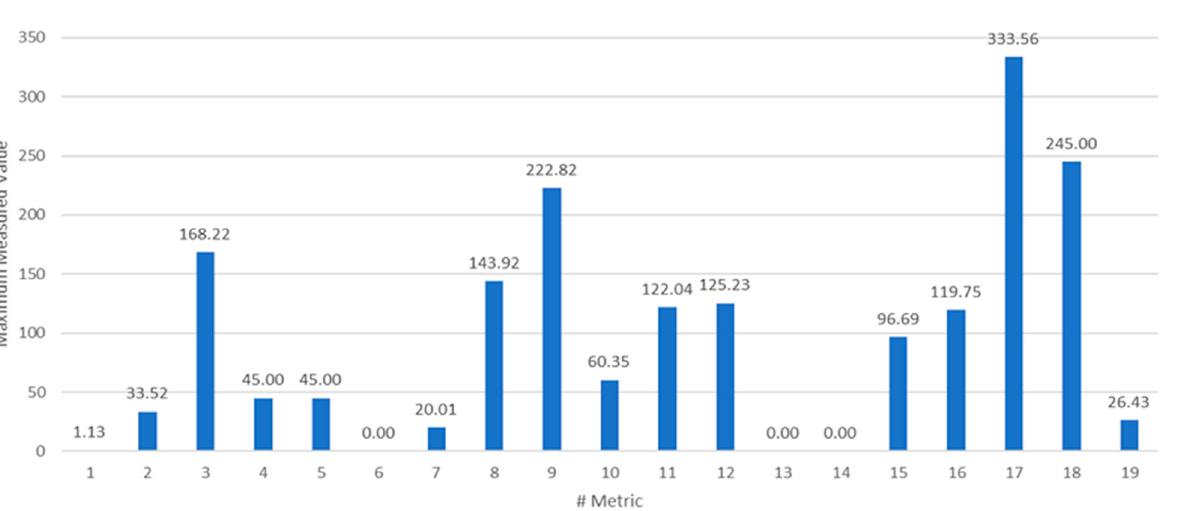
Figure 15. Metrics normalized to the maximum measured values. 6. Experimental Results In this section, we illustrate the application of the Bayesian estimator to real data metrics. Specifically, we assume that the metrics are affected by generic acquisition noise, and we prove that they are corrected by the estimator. The nonlinearity parameters p 0 and β 0 are assigned values of 0.1 and 0.8, respectively. Regarding the assignment of the β 0 pa- rameter value to 0.8, it reflects the hypothesis of good accuracy in the observed data. The value attributed to p 0 is in accordance with the high degree of confidence in the LCMS technology in detecting defects. It should be noted that the proposed method could also be applied considering data collection methods with less accuracy than those of the LCMS, defining lower values of the parameter β 0 . Herein, we aim at assessing the performance of the model for various real pavement distresses.